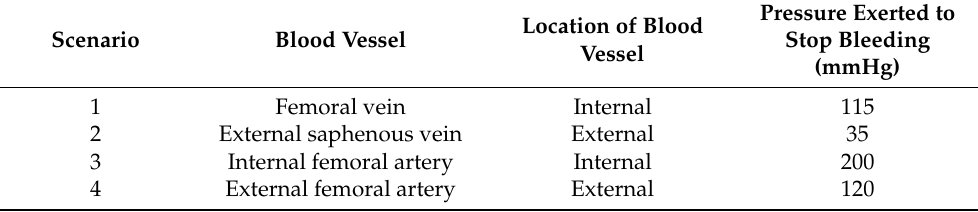
Table 3. Scenarios in which the lesion could happen classifying the blood vessel depending on the type, vein or artery and on the location of the blood vessel, internal or external. Additionally, the needed pressure to stop the bleeding is stated in